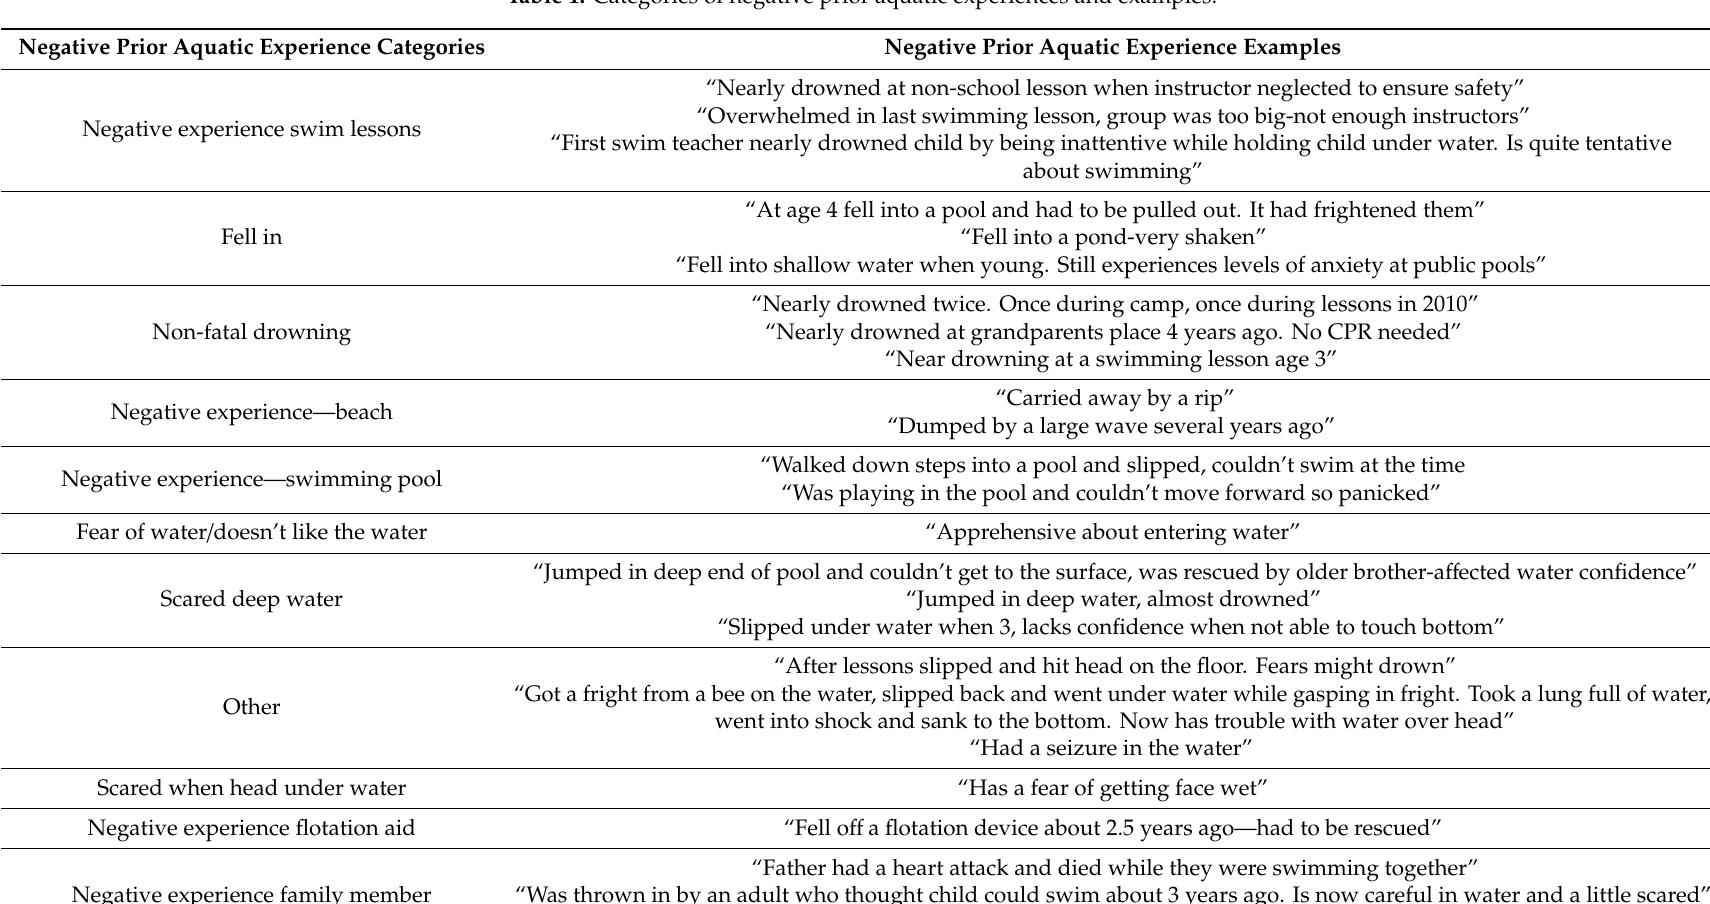
Table 1. Categories of negative prior aquatic experiences and